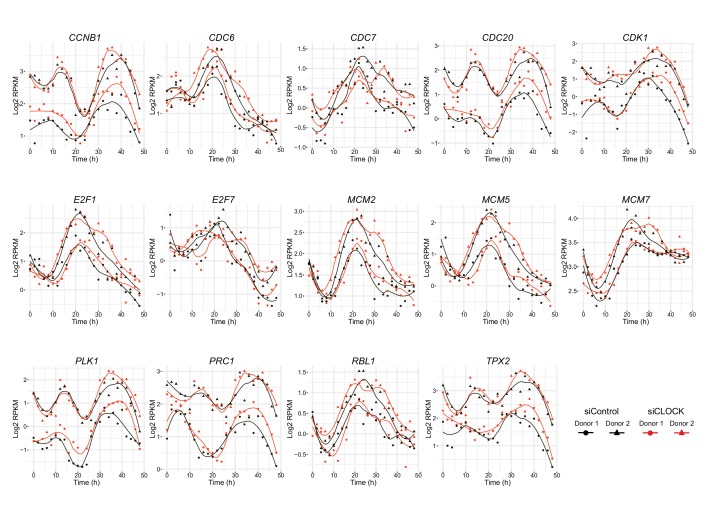
Genes involved in cell cycle regulation exhibit circadian expression profile in hSKM.CCNB1, CDC6, CDC7, CDC20, CDK1, E2F1, E2F7, MCM2, MCM5, MCM7, PLK1, PRC1, RBL1/p107 and TPX2 expression profiles obtained by RNA-seq. All genes shown were classified in model 1 except for E2F1 and MCM5 (model 3).